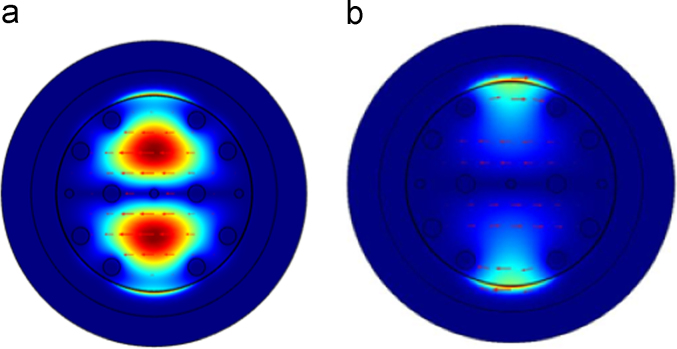
(a) Surface mode and (b) SPP mode of proposed structure for λ=0.70 µm and na=1.37 nm.